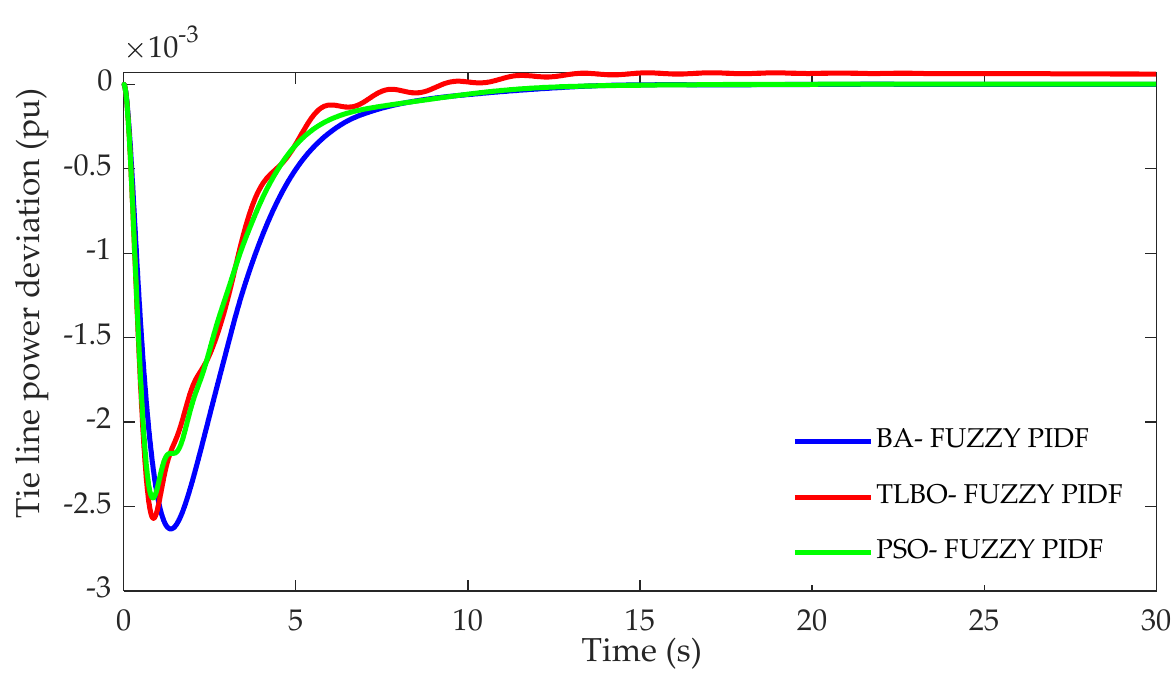
Figure 11. Tie-line power deviation ( ∆ P tie in pu) under parametric uncertainties of the testbed system. Table 7. Frequency response performances with different controllers for parametric uncertainties analysis.